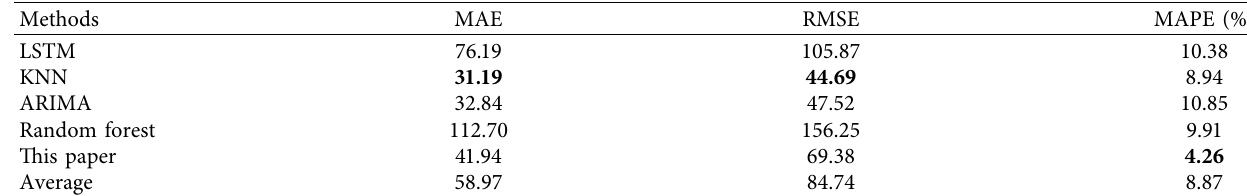
Table 5: Compare evaluation indicators with diferent models using fow